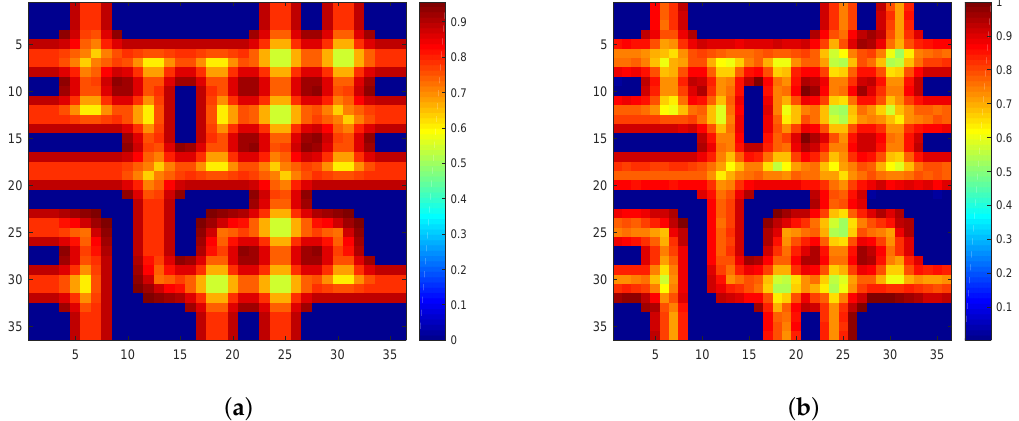
Figure 3. ( a ) The real sparseness map of synthetic data; ( b ) The estimated sparseness map of synthetic